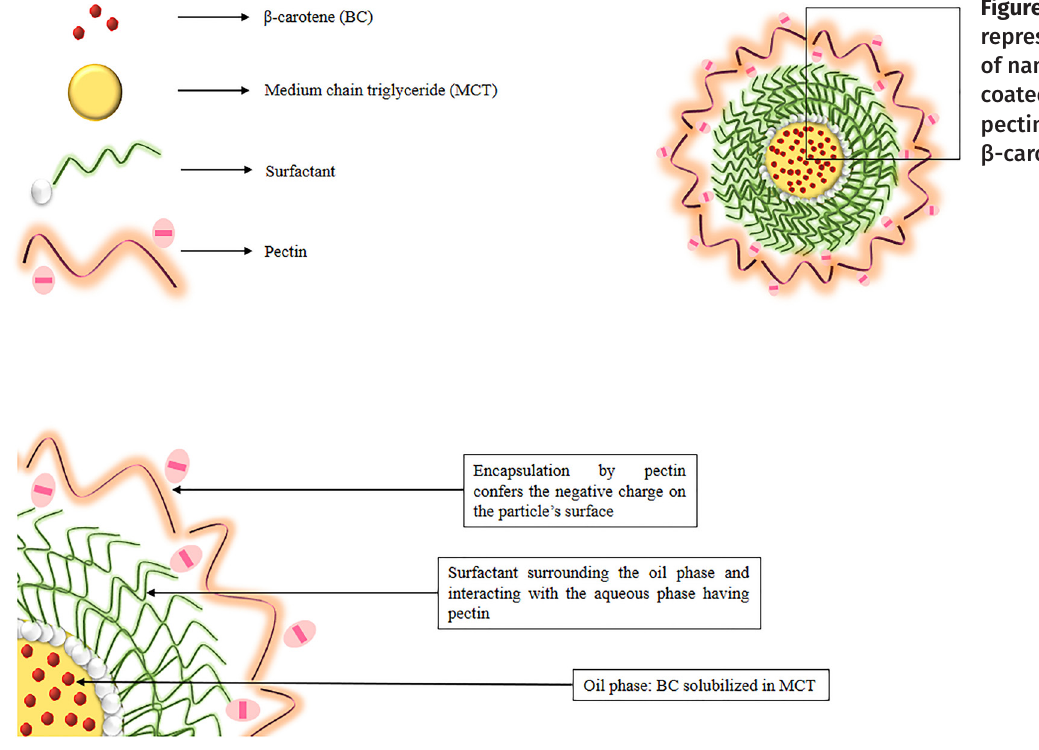
Figure 4. Schematic representation of nanoparticles coated with pectin containing